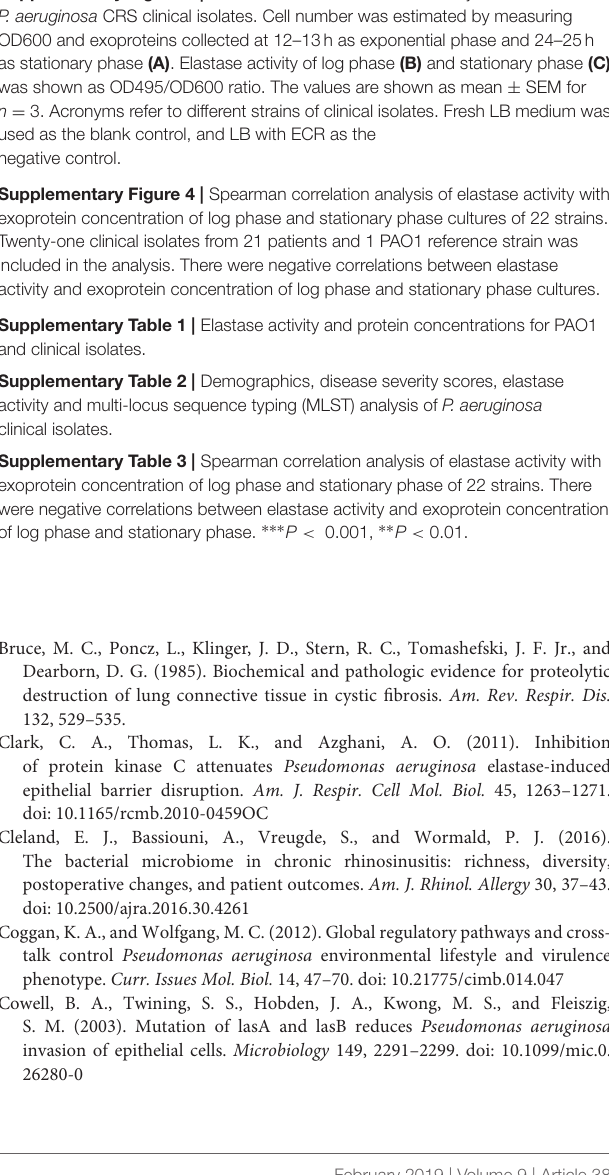
Supplementary Figure 1 | Growth curves of P. aeruginosa and Lactate Dehyrogenase (LDH) assays. Growth curves from 3 P. aeruginosa clinical isolates